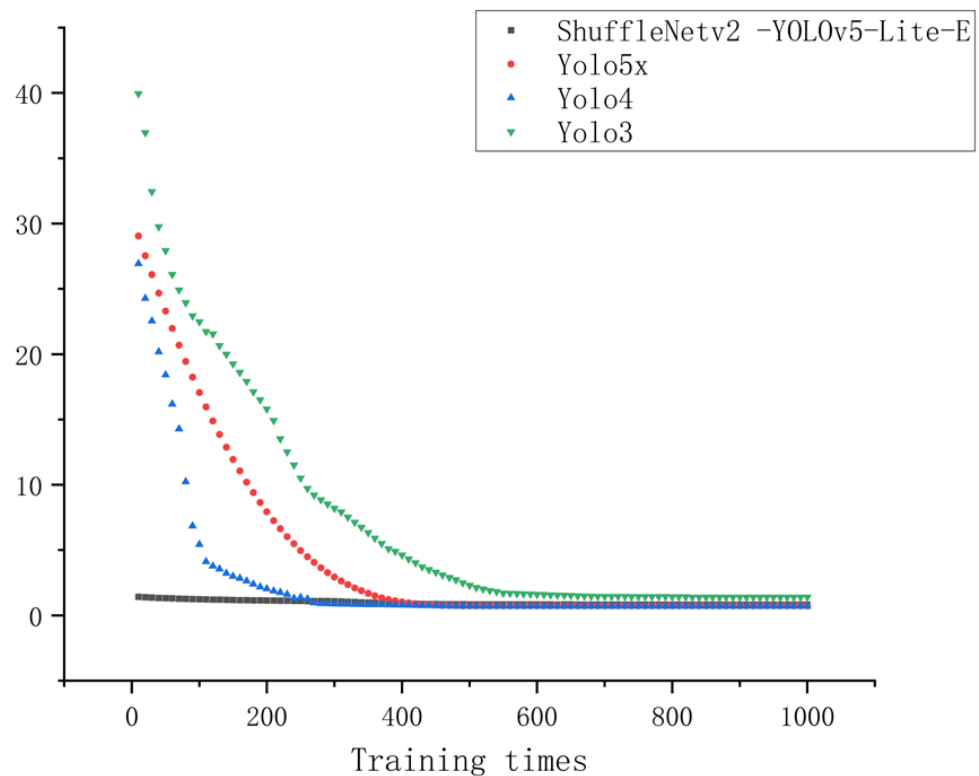
Figure 6. Comparison of loss changes.